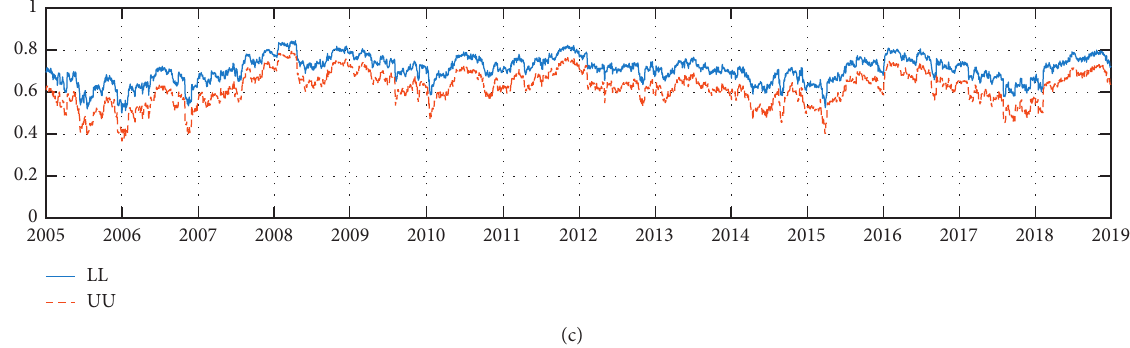
Figure 20: 10% QD coefficient series of the multivariate DCC-NCCN copula model. (a) HSI-CEI. (b) HSI-CCI. (c)